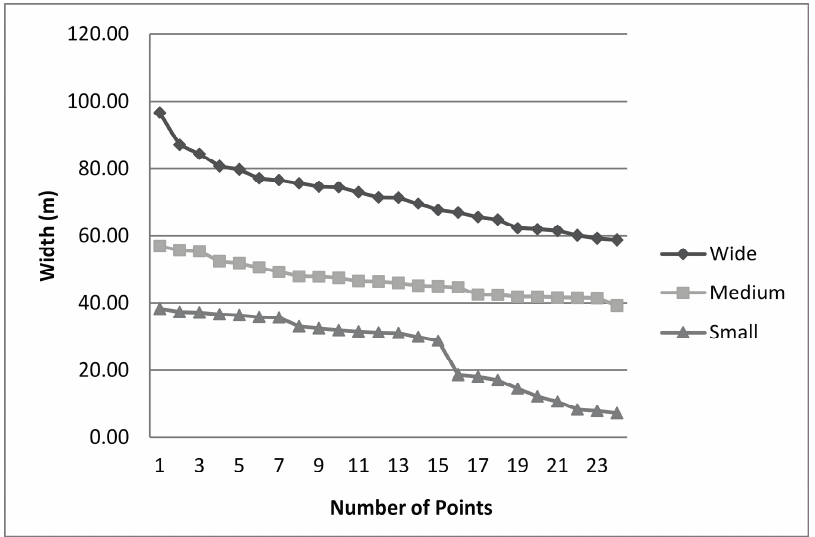
Figure 4. The width of the selected river transects across the area subdivided in three